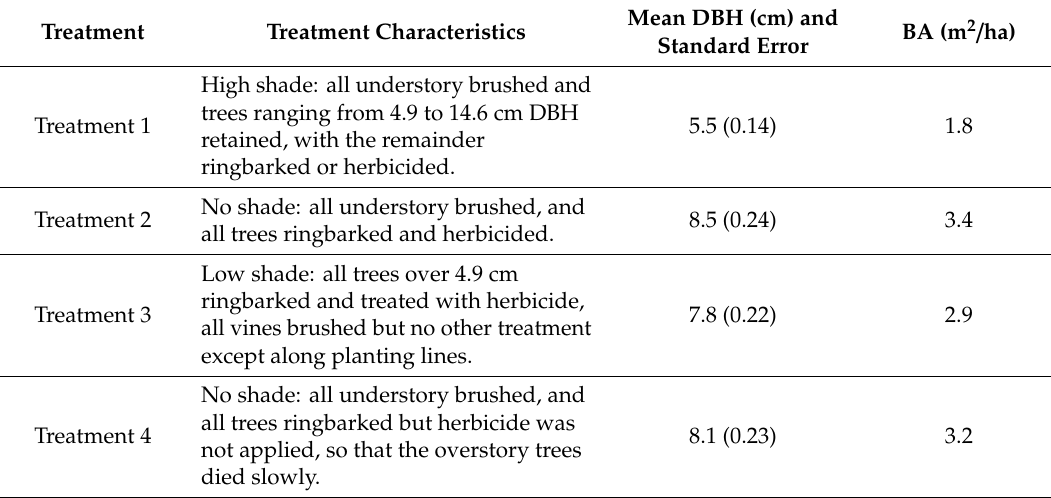
Table 4. The diameter at breast height (DBH) (and standard errors) and the basal area of Flindersia brayleyana at age 14 under di ff erent tending regimes in experiment 373. The mean DBH of all four treatments were significantly di ff erent ( p <